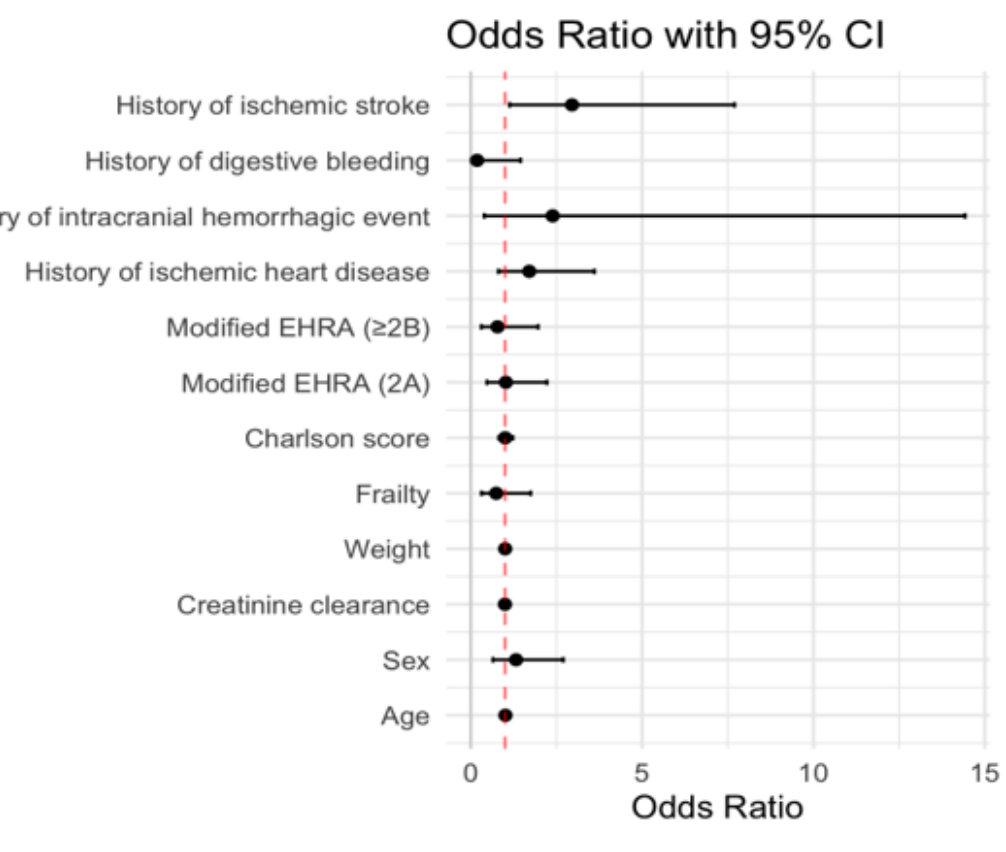
Figure 3. Forest plot of variables influencing NOAC ( a ) underdosing and ( b )